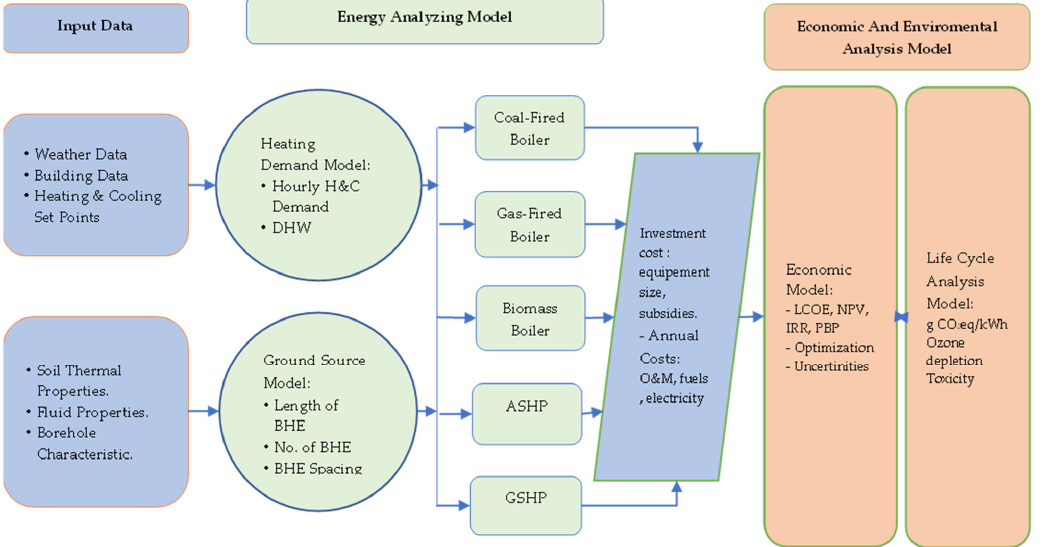
Figure 8. The proposed methodology for techno-economic modelling.